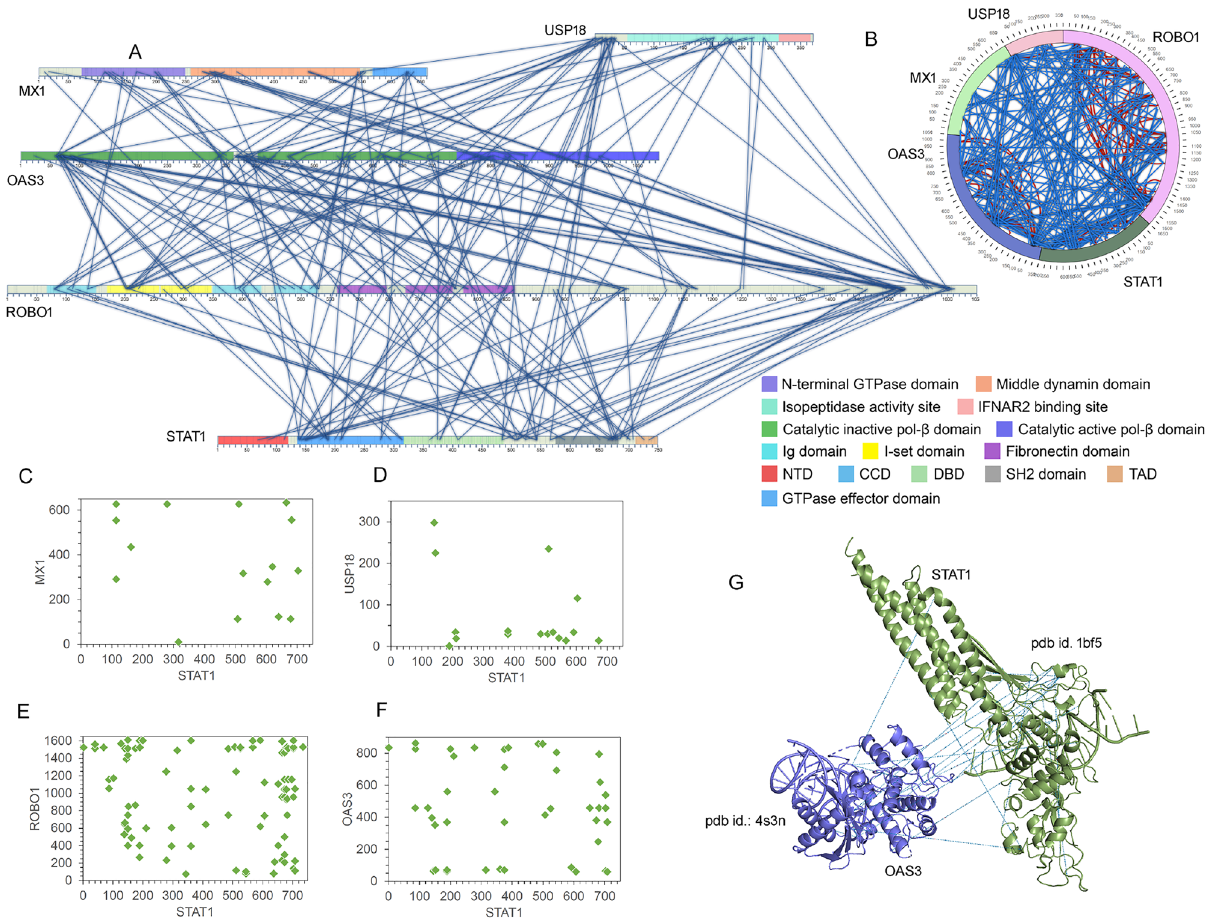
Figure 4. Protein–protein intermolecular network of ISGs identified in the IFNα treated cross-linked cells. (A) 2D interactive map (generated in SIM-XL program 29 ) showing the protein–protein interactions, the lines represent intermolecular interactions (cross-link score cut-off was set to 3.5). Domains of different identities are labeled with their respective colors 32 : MX1 domains; Dynamin_N (73–249), Dynamin_M (259–547), and